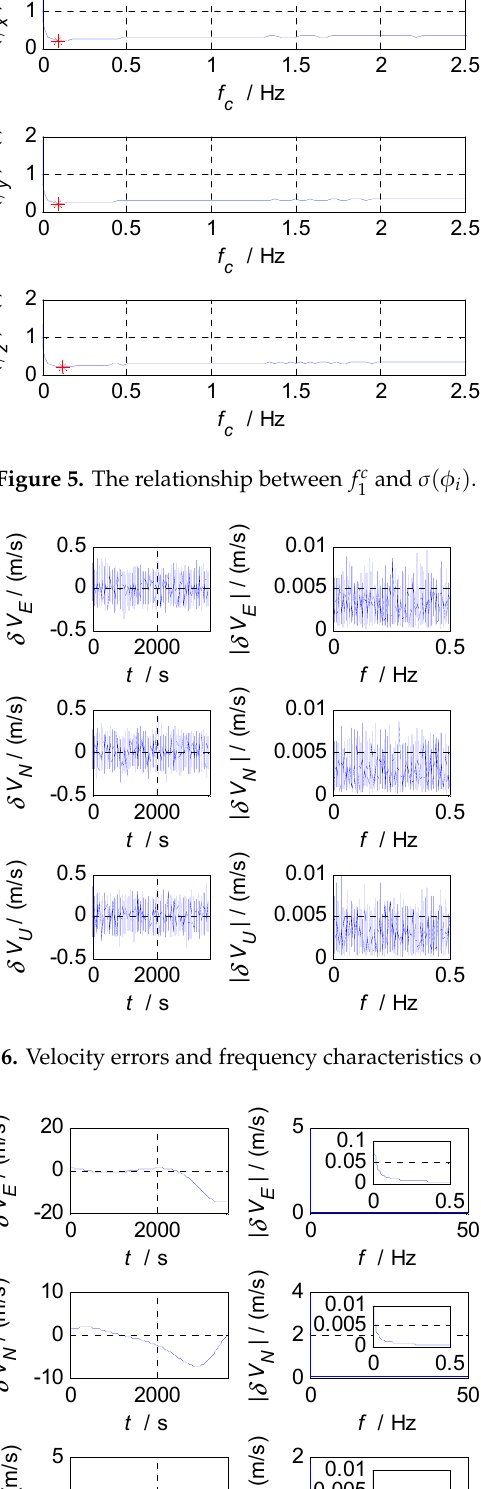
take different values, and